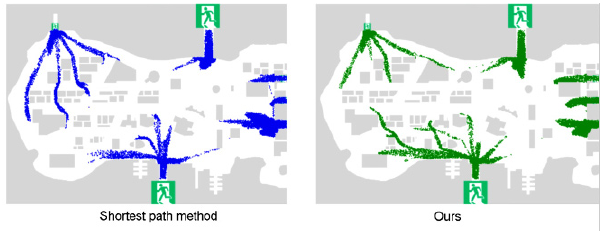
Fig. 15 Evacuation by ferry. Agents have to take ferries to leave the top left corner, causing evacuation from this direction to be slow. Our system thus guides more agents to other exits.